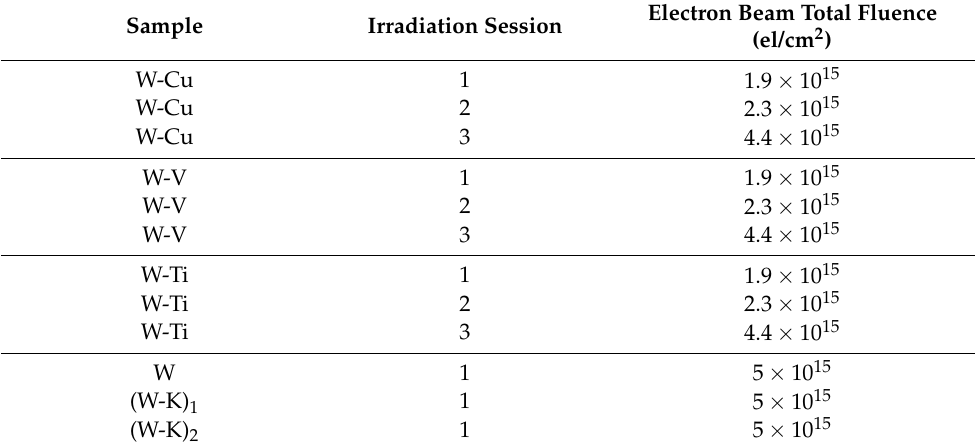
Table 1. Table with sample type, irradiation session and total EB fluence during a session. Each session lasts for 10 min.